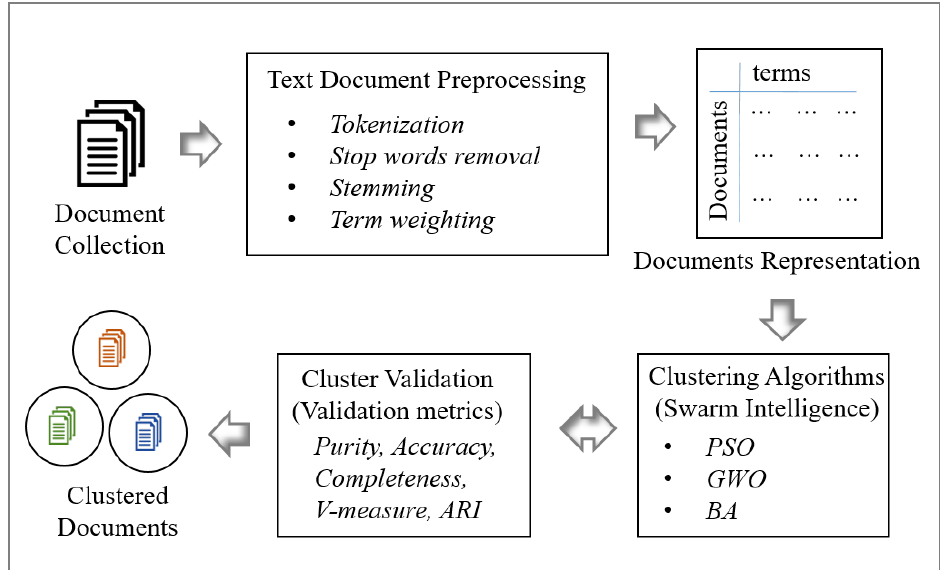
Figure 1. Process of text document